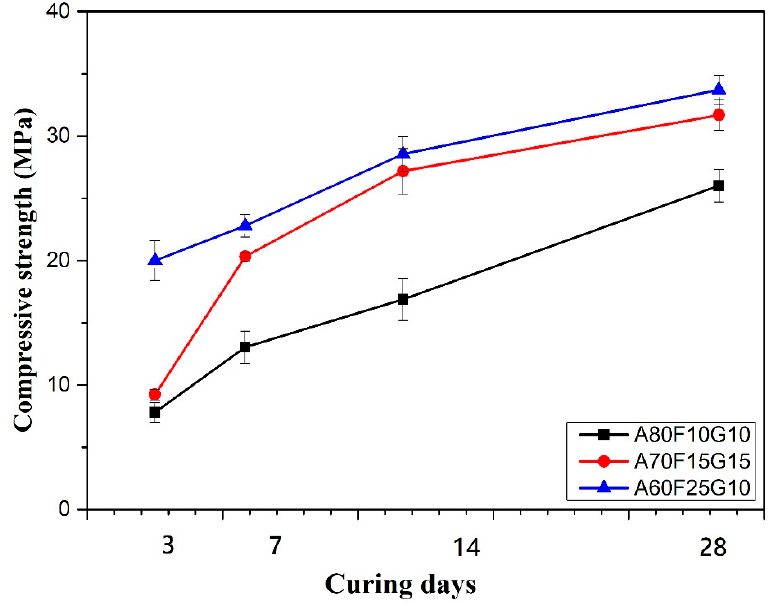
Figure 12. Effects of AS/FA ratio on the compressive strength of AFG geopolymer mortar.